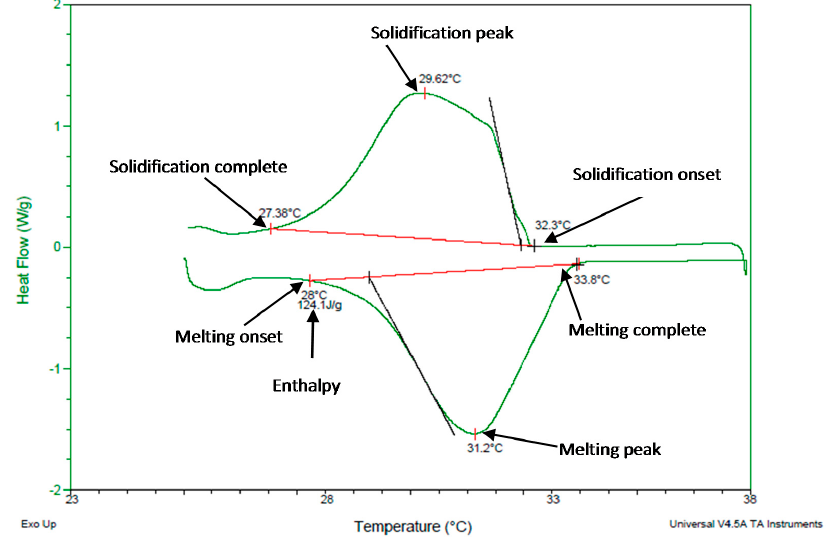
Figure 10. Thermogram of PCM using DSC.